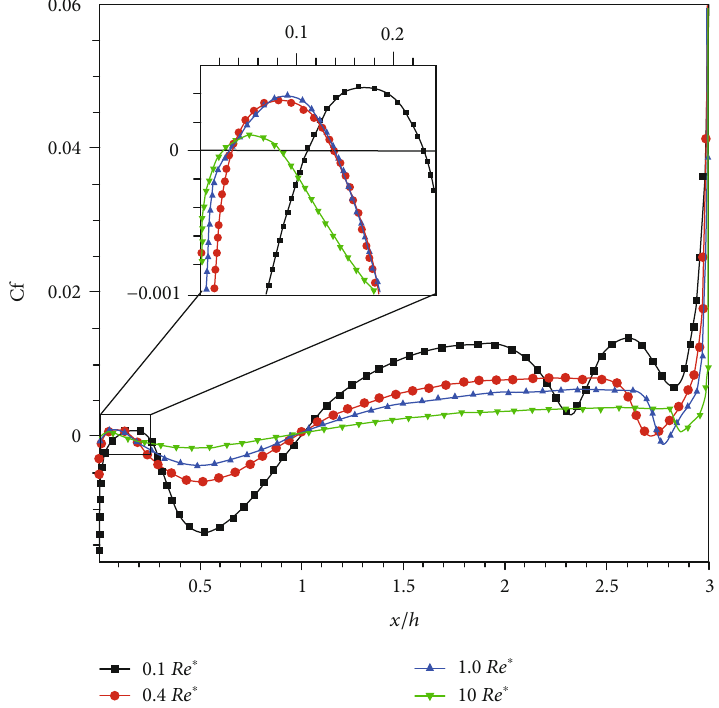
Figure 14: E ff ect of the Reynolds number on the friction coe ffi cient of the bottom